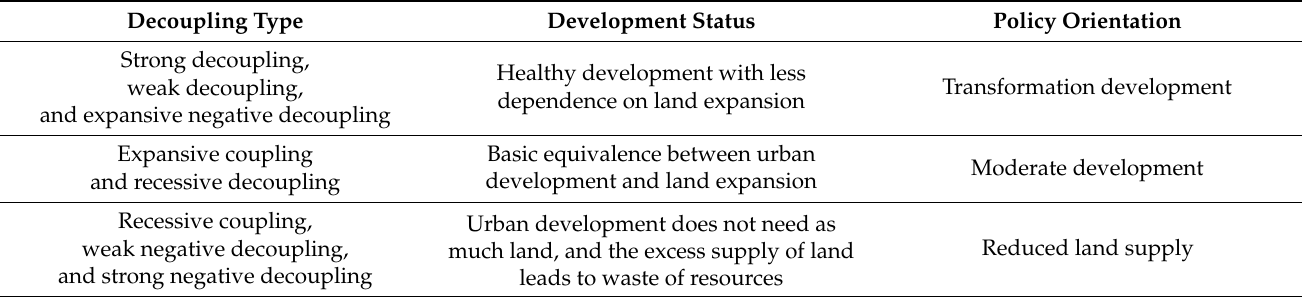
Table 3. Statistical analysis of average annual growth